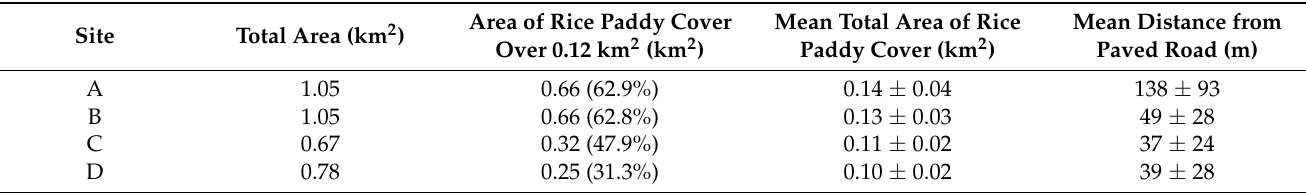
Table 2. Descriptive statistics for the two environmental variables having the largest effect on habitat suitability for Dryophytes suweonensis in Siheung, Republic of Korea. These two variables are rice paddy cover and distance from paved road, extracted from 36 points where D. suweonensis were observed in 2012, 2015 and 2019. The data is provided broken down by sites A, B, C and D (details on Figure